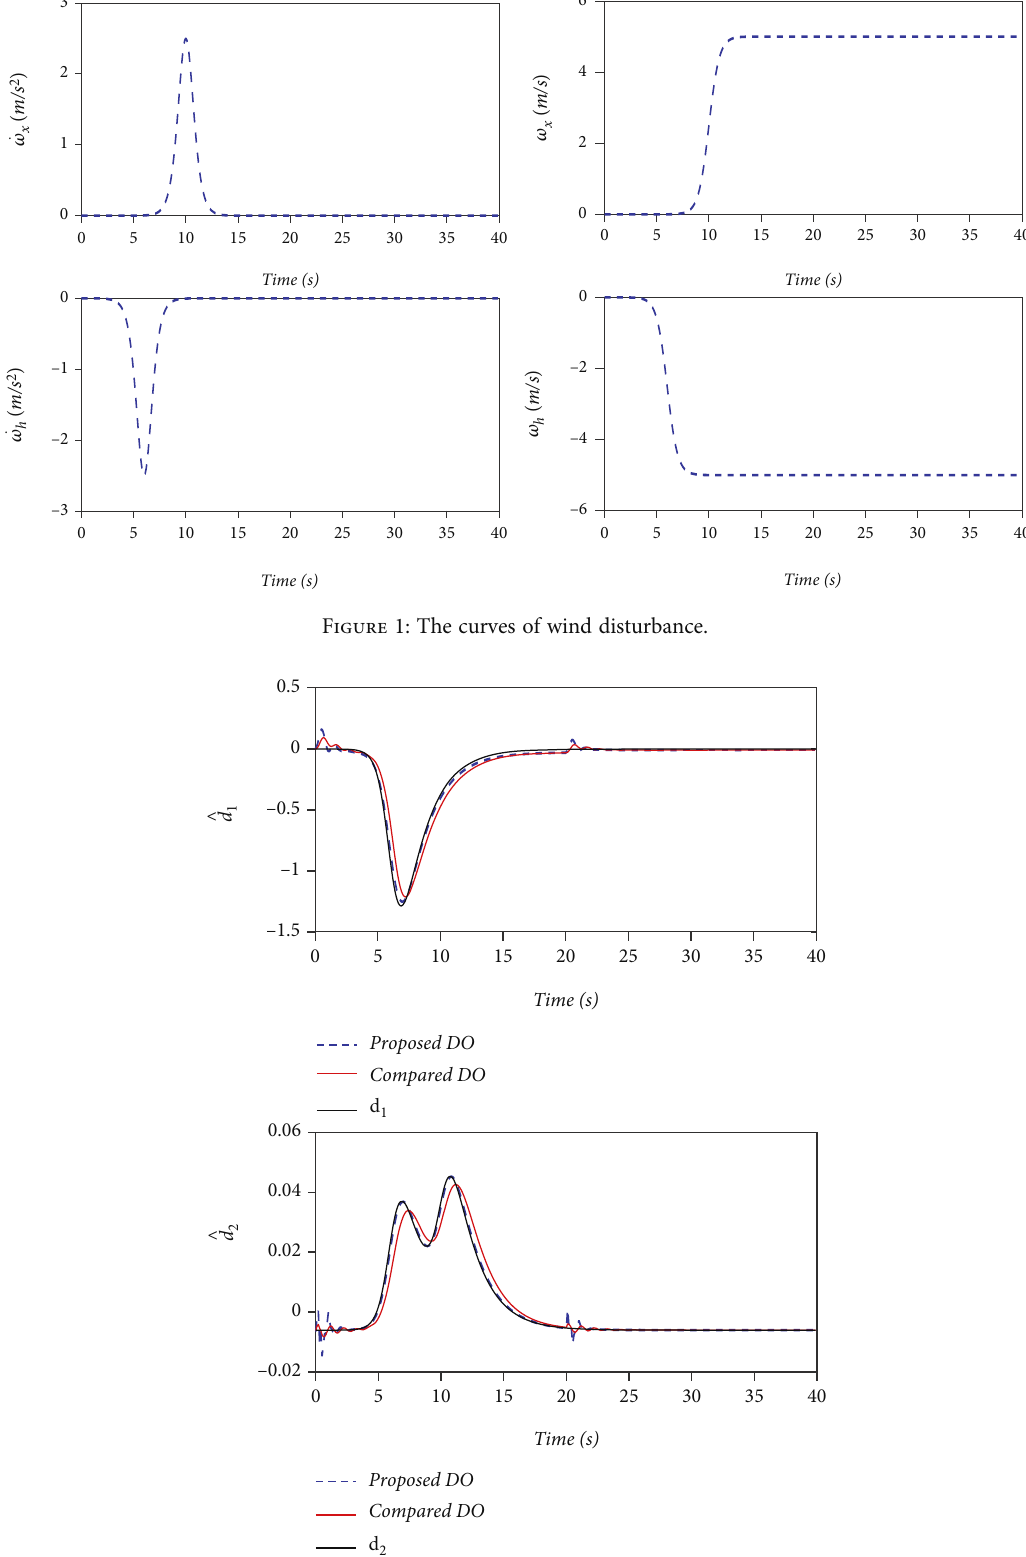
Figure 2: Estimation of d